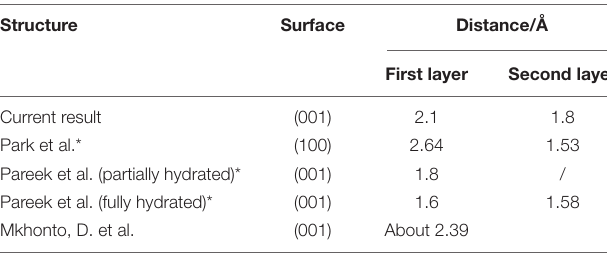
TABLE 5 | Summary of the current calculation and previous experimental results of the layer spacing of adsorbing